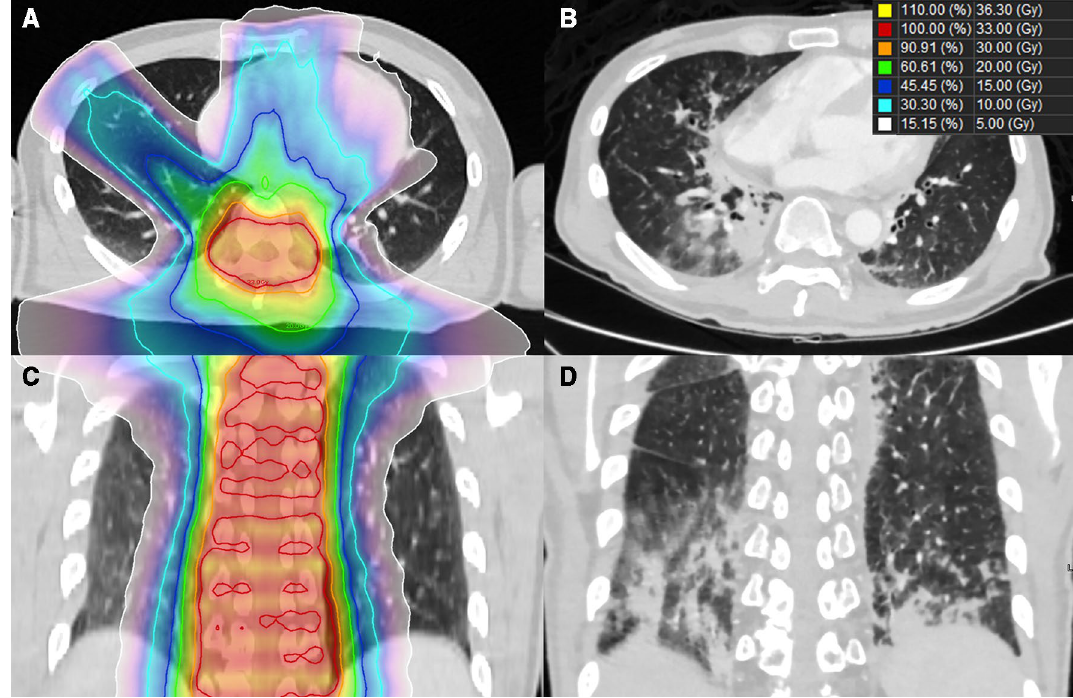
Figure 1. A 52-year-old man in whom grade 2 radiation pneumonitis developed 82 days after initiation of radiotherapy for leptomeningeal carcinomatosis of malignant melanoma. ( A, C ) Dose distribution for craniospinal irradiation and ( B, D ) radiation pneumonitis in computed tomographic image. Total patients Pediatric patients Univariate analysis Multivariate analysis Univariate analysis Multivariate